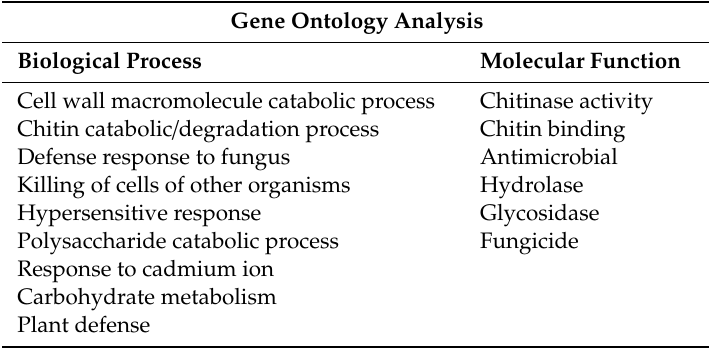
Table 2. The predicted gene ontology (GO) analysis of chitinase gene CaChiIII7